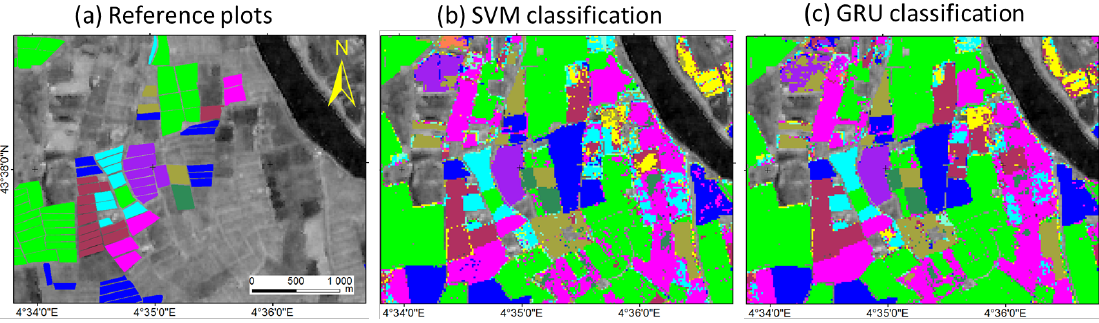
Figure 9. A zoom version of the white-border box in the Figure 8 is provided to facilitate visualization of classification results. ( a ) reference plots; ( b ) the classical SVM result and ( c ) the RNN-based GRU